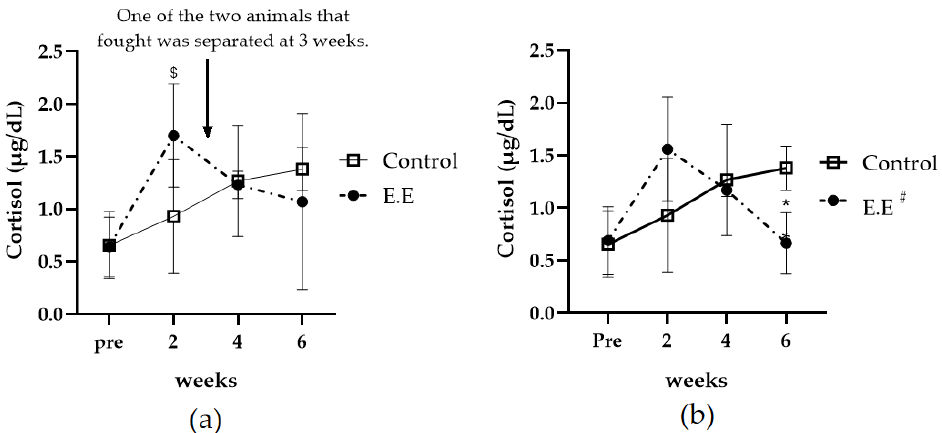
Figure 5. Change in cortisol concentration in collected serum at 2-week intervals, including before environmental change of placing them into the cages (pre) for a total of 6 weeks when the fighting dog was ( a ) included and ( b ) not included. # Except for one dog that fought. E.E: Environmental enrichment group. $ p < 0.05 vs. pre, * p < 0.05 vs. control group.